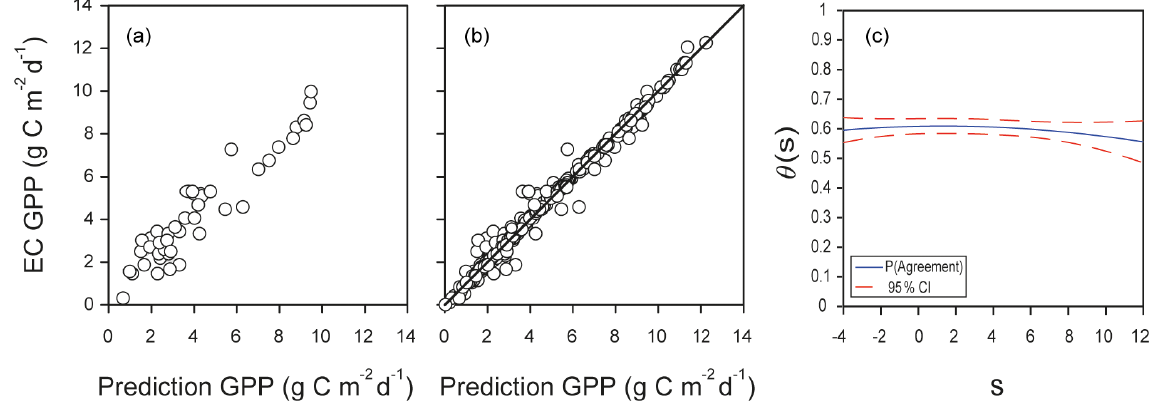
Figure 9. Agreement between predictions of GPP obtained with machine learning algorithms or derived from eddy covariance measurements at the Bernal site. (a) Example of one run of predictions of GPP in the test dataset from the Bernal site using the leader model of an ensemble of machine learning algorithms (EML); the test dataset was 15% of data, with r = 0 . 94. (b) Predictions for the complete dataset, with r = 0 . 99; the diagonal line is the 1 : 1 agreement. (c) Function of probability of agreement using 1gCm − 2 d − 1 as a tolerable agreement between methods of estimation of GPP corresponding to plot (b) . The horizontal axis ( s ) represents the magnitude of the measurement, the vertical axis is the probability of agreement for the measurement, and the red line is the confidence interval p < 0 . 05 .